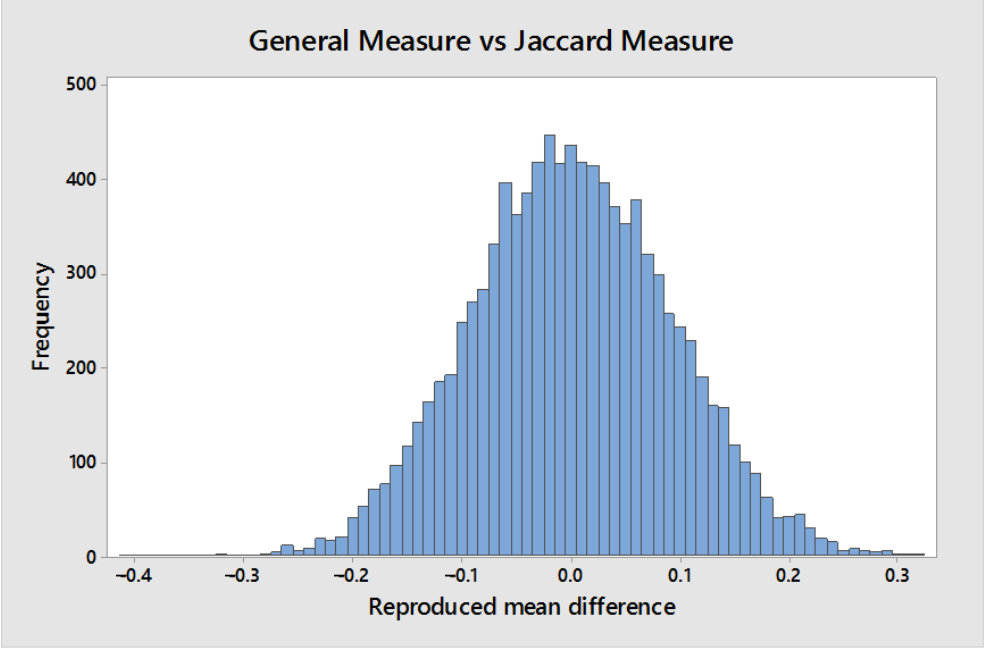
Figure 14. Permutation test